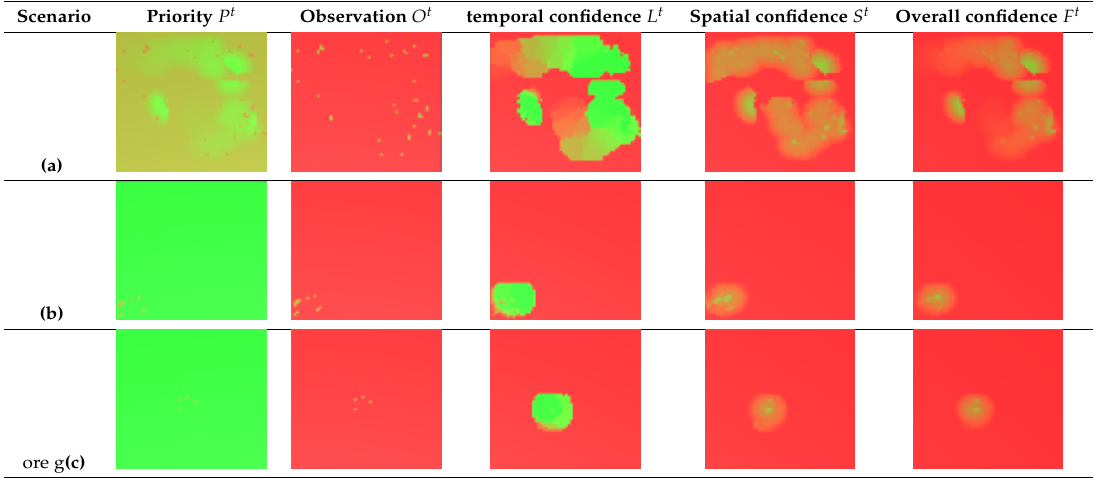
Figure 7. Graphical representation of priority P t , observation O t , temporal confidence L t , spatial confidence S t and overall confidence F t for 3 different scenarios: ( a ) Camera network sample, ( b ) tracking sample at time t = 0, ( c ) tracking sample at time t = 10. In ( b , c ) the UAV focuses on the observation matrix, such that the next priority map depends only on previous observations. Red represents the value 0, and green represents the value